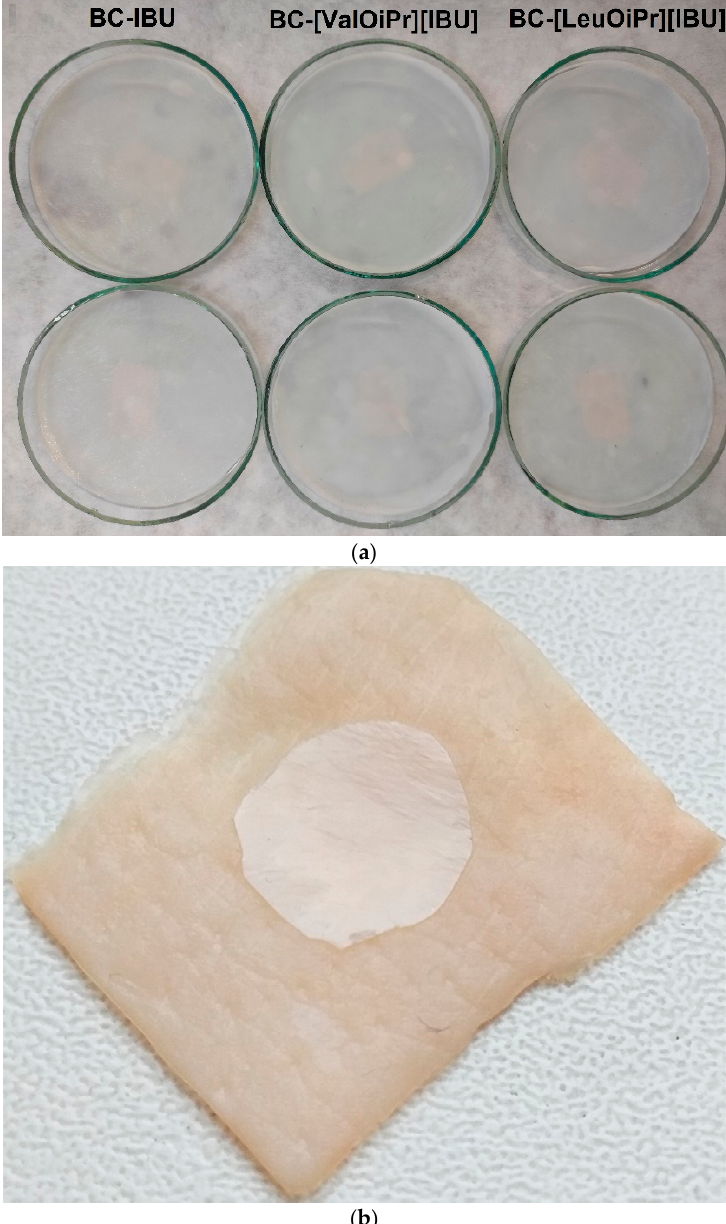
Figure 1. ( a ) Images of BC-IBU, BC-[ValOiPr][IBU] and BC-[LeuOiPr][IBU] dry membranes and ( b ) one example (BC-[LeuOiPr][IBU] membrane) showing good dermal adherence.